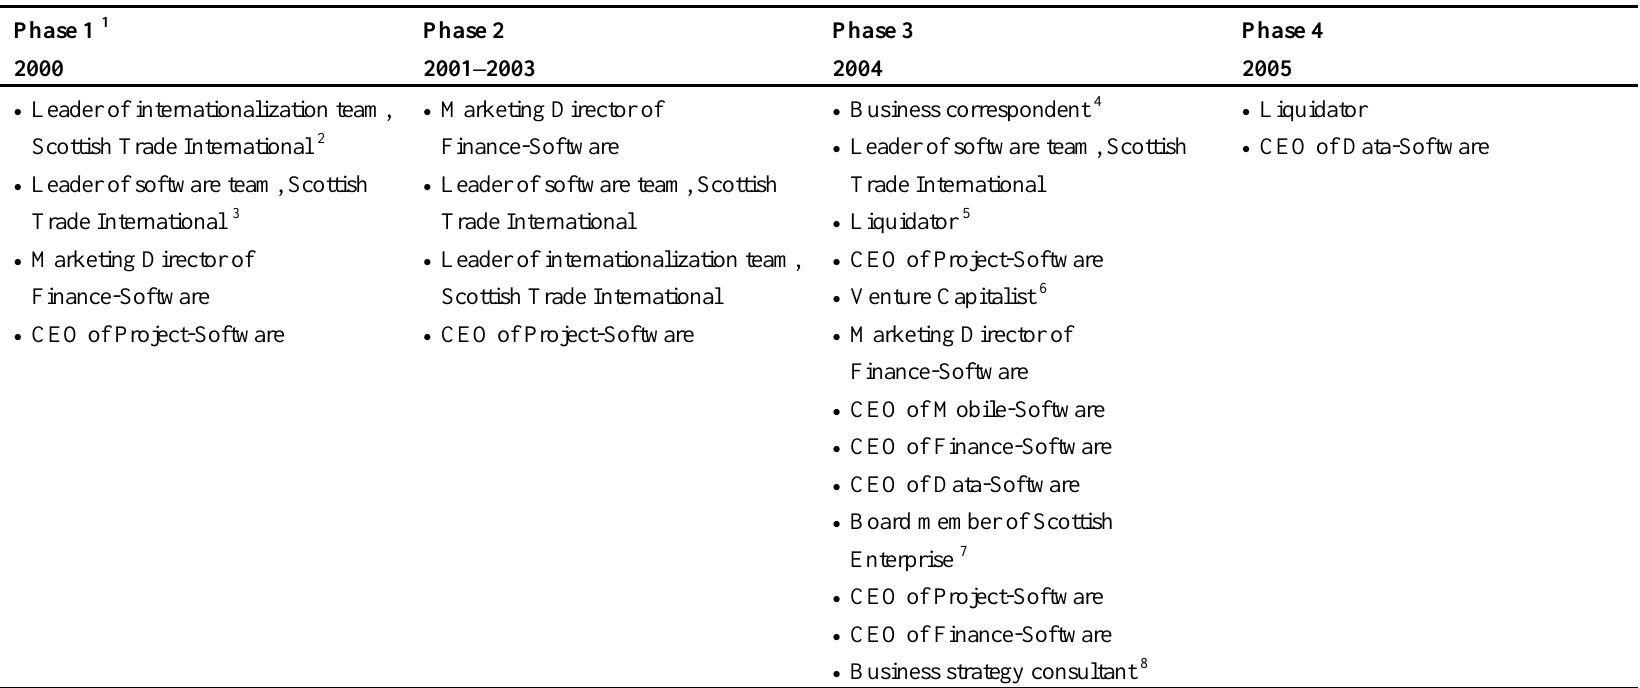
Table 2. Data collection and